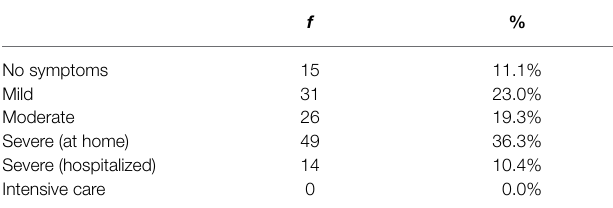
TABLE 3 | The course of the